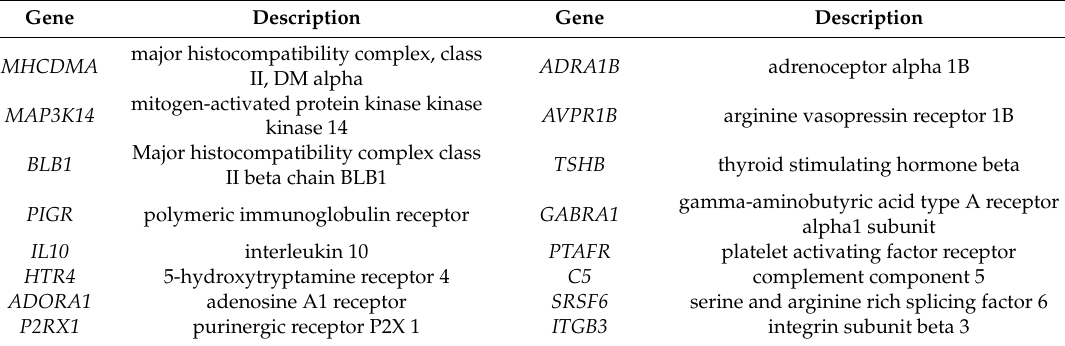
Figure 6. Kyoto Encyclopedia of Genes and Genomes (KEGG) pathway enrichment analyses of di ff erentially expressed genes. ( a , b ) Top 10 enriched KEGG pathway in P-F-O1 vs. P-F-O2 and L-F-O1 vs. L-F-O2. The Y axes represent the name of pathway, the X axes represent richness factor (di ff erentially expressed genes enriched in this pathway / total genes in this pathway). Table 2. Di ff erentially expressed genes enriched in the five pathways from P-F-O1 vs. P-F-O2 and L-F-O1 vs.